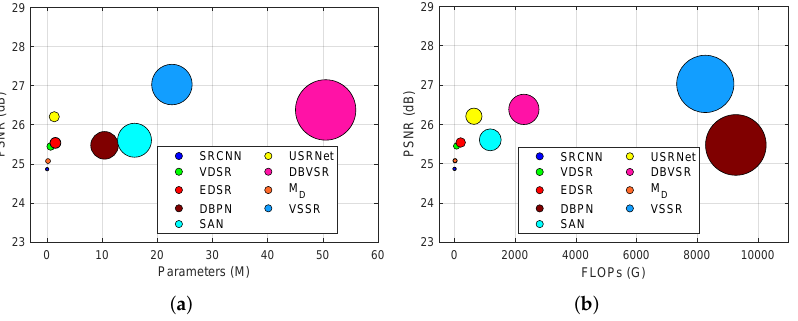
Figure 10. Comparisons of the VSSR against other DL-based approaches. ( a ) compares the number of parameters. ( b ) compares the FLOPs when we acquit a 1280 × 1280 video frame. ( a ) Parameters and PSNR. ( b ) FLOPs and